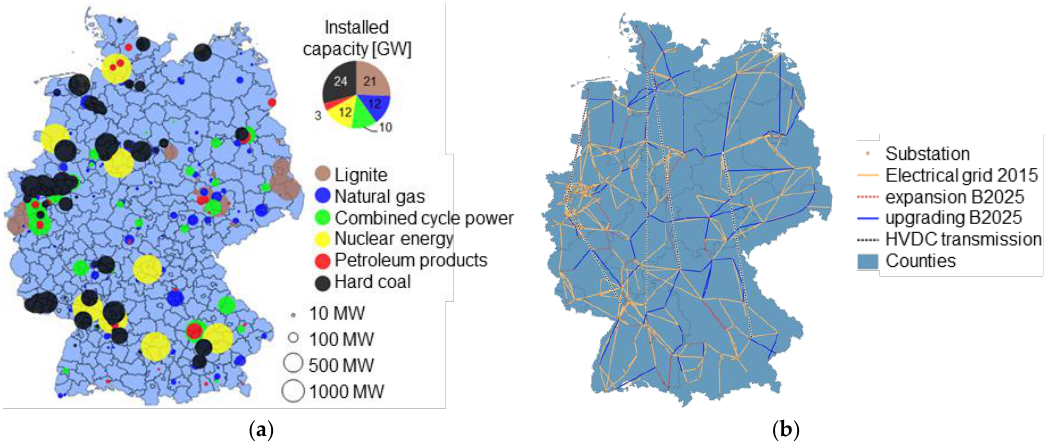
Figure 6. Location and installed capacities of conventional power plants in Germany ( a ); and transmission lines at 380 and 220 kV, in addition to high voltage direct current transmission ( b ). Data according to: Bundesnetzagetur (2013) [46] ( a ); and Ü bertragungsnetzbetreiber (2016) [32] ( b ).